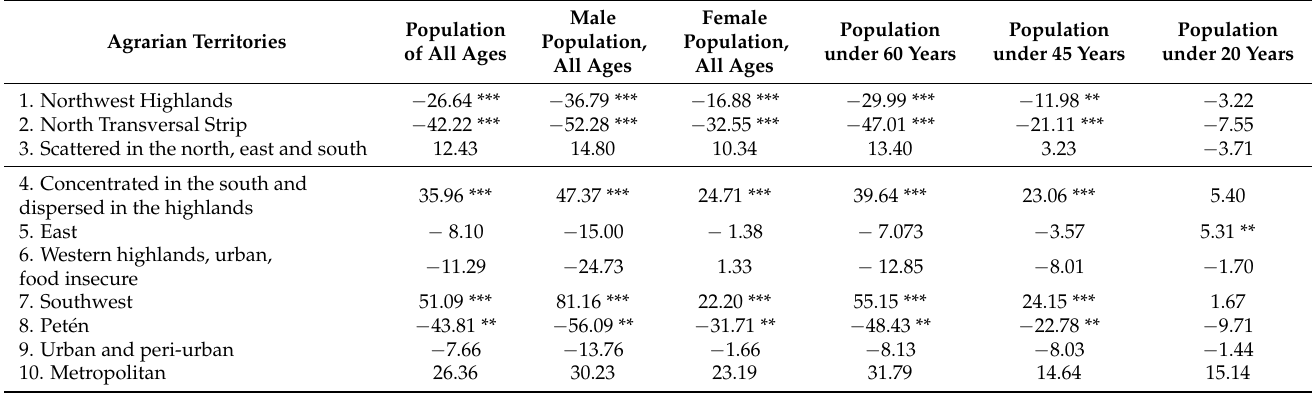
Table 4. Bivariate linear regression coefficients for agrarian territories and municipal mortality rates for chronic kidney disease, by gender and age group, Guatemala 2009–2019 ( N = 28,723).